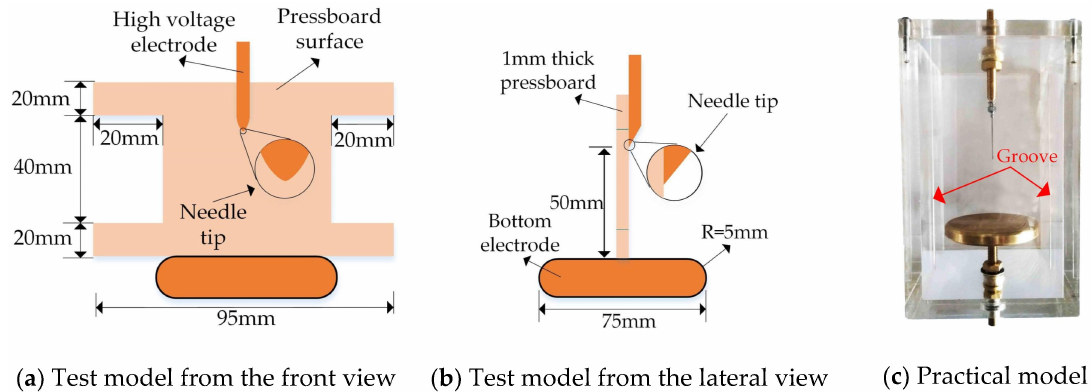
Figure 3. The needle-plate electrodes model for tests.